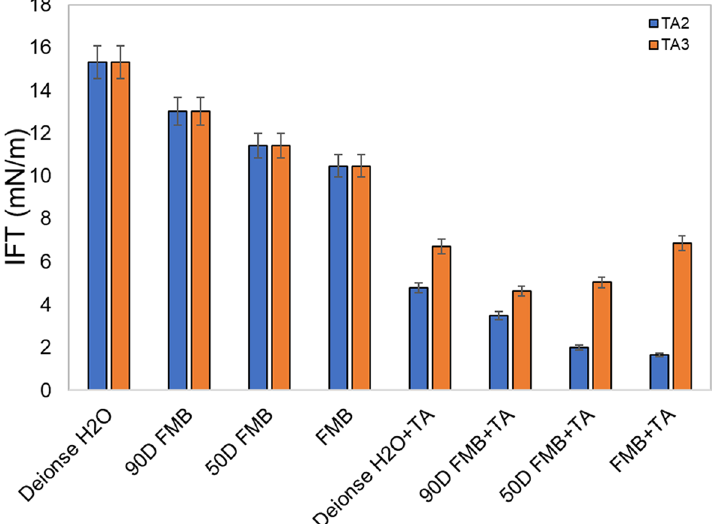
Fig. 8 Effect of varied brine salinity on oil-brine IFT with and without